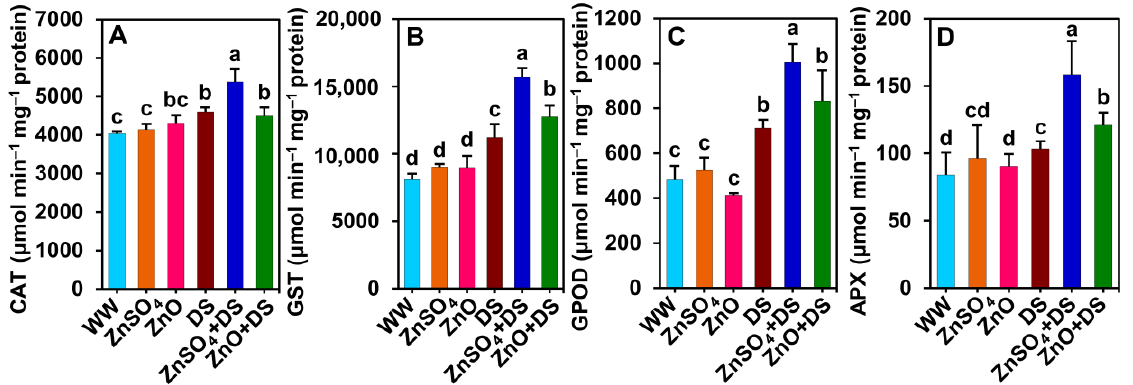
Figure 5. Effect of separately applied ZnSO 4 (1.0 g Kg −1 soil) and ZnO (1.0 g Kg −1 soil) on the activities of ( A ) catalase (CAT), ( B ) glutathione S -transferase (GST), ( C ) guaiacol peroxidase (GPOD), and ( D ) ascorbate peroxidase (APX) in the leaves of cotton plants that were subjected to water deprivation-induced drought stress for 6 days. The means and standard deviations ( n = 3) are displayed as bars. Significant changes ( p < 0.05) among the treatments are denoted by different letters (a–d) above the bars as calculated using the least significant difference test. Here, the treatments are well-watered plants (WW), ZnSO 4 -supplemented well-watered plants (ZnSO 4 ), ZnO-supplemented well-watered plants (ZnO), drought-stressed plants (DS), ZnSO 4 -supplemented drought-stressed plants (ZnSO 4 + DS), and ZnO-supplemented drought-stressed plants (ZnO +